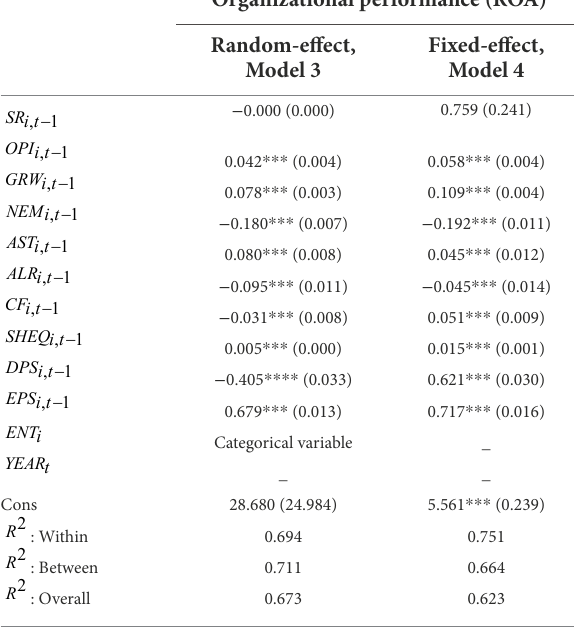
TABLE 4 Estimation results for the impact of investor